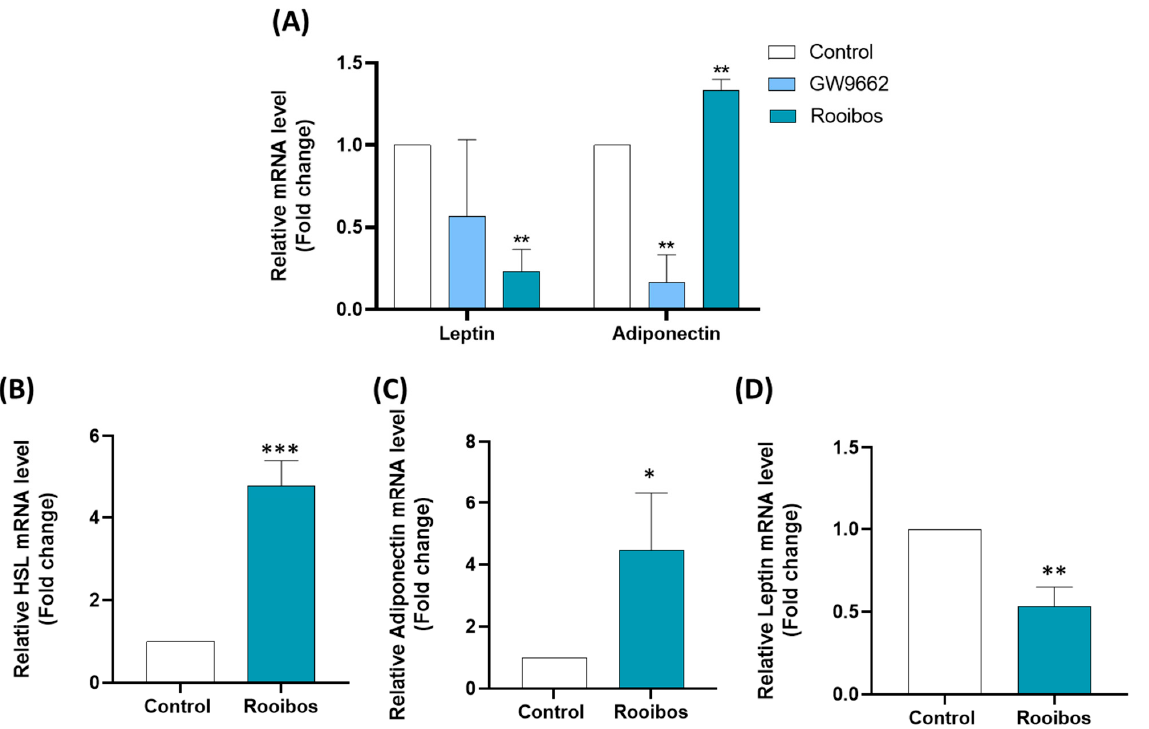
Figure 4. Adipokine expression in human adipocytes is affected by Rooibos treatment. Cells were exposed to 50 µg/mL of Rooibos extract for the full differentiation period. Total RNA isolated from untreated cells was used as the control. Data shown are the relative mRNA expression of leptin and adiponectin ( A ), normalized to β -actin . Cells were differentiated normally, and mature adipocytes were treated with 50 µg/mL Rooibos for 24 h. Total RNA isolated from untreated cells was used as the control. Data shown are the relative mRNA expression of HSL ( B ), adiponectin ( C ) and leptin ( D ), normalized to β -actin . Significance is indicated as * where p ≤ 0.05, ** where p ≤ 0.01 and *** where p ≤ 0.001 and n = 3.